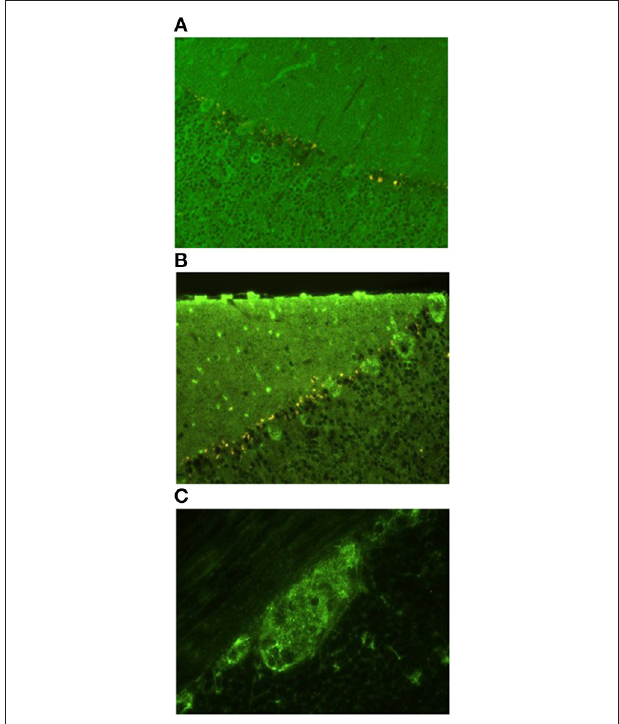
FIGURE 2 | Indirect immunofluorescence assay on primate cerebellar and intestinal sections. (A,B) Granular cytoplasmic and dendritic fluorescence of Purkinje cells and a granular fluorescence of the molecular and granular cerebellar layers. (A) Sera in dilution 1:100, (B) undiluted CSF. (C) Granular cytoplasmic fluorescens of neurons in the intestinal plexus myentericus. Undiluted CSF.